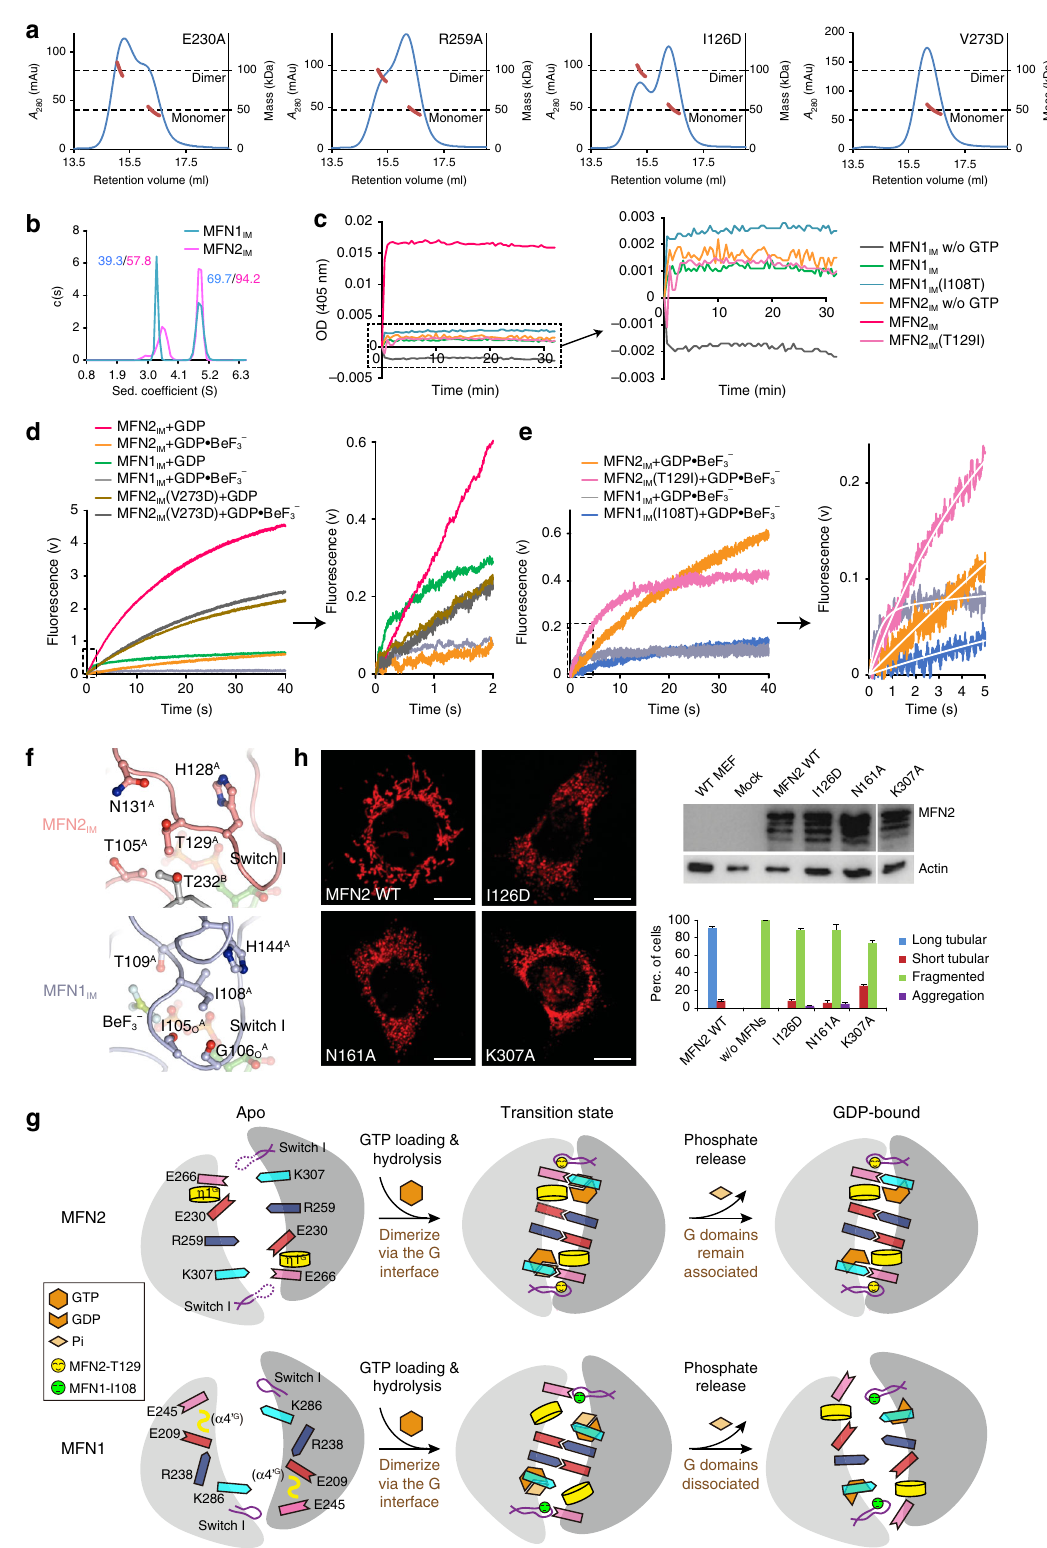
MFN2 IM bound more mant-GTP over time due to a higher To examine how G domain dimerization affects GTP turnover rate, we designed a nucleotide exchange assay by instantaneously af fi nity to GTP as compared with MFN1 IM , the mant-GTP reload to MFN2 IM was much slower. G domain dimerization greatly mixing preincubated MFN1/2 IM -GDP (monomeric) or MFN1/ 2 IM -GDP (cid:1) BeF (cid:3) reduced the mant-GTP reload rate of both MFN2 IM and MFN1 IM (dimeric) with fl uorescently-labeled GTP (mant- 3 (Fig. 4d). MFN2 IM (T129I) and MFNI IM (I108T) showed pro- GTP) using stopped- fl ow. The initial slope of the fl uorescent moted and reduced mant-GTP reload rates compared with increase indicates the ef fi ciency of mant-GTP reload. Although